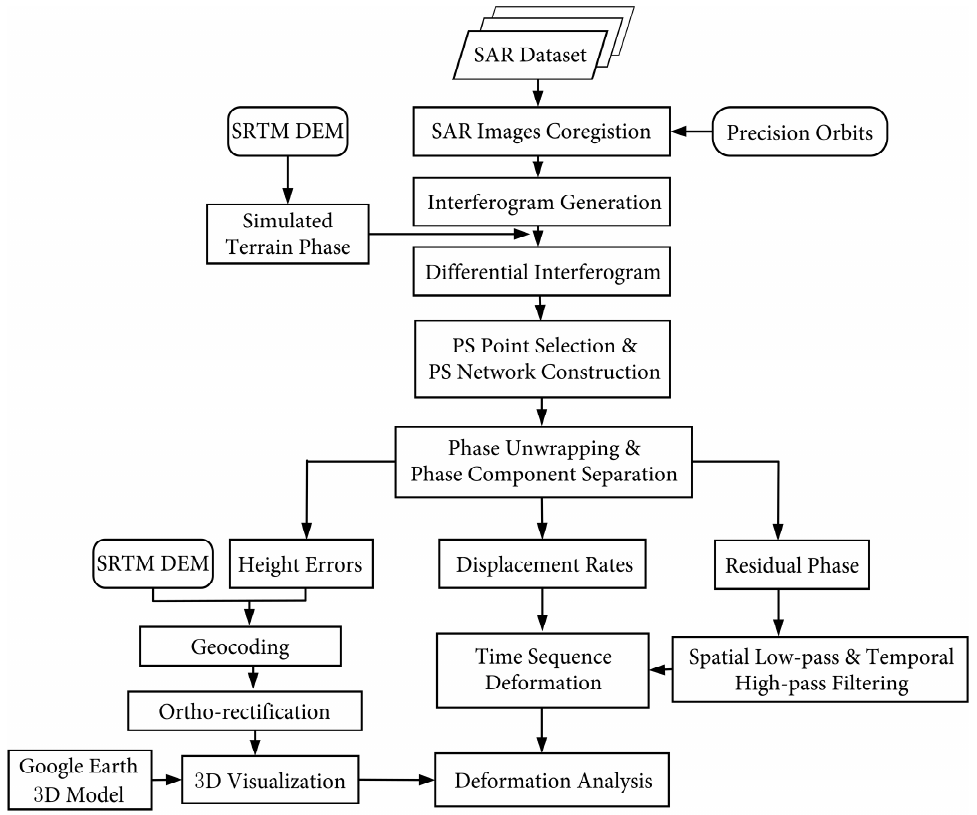
Figure 3. Flowchart of high-resolution permanent scatterer interferometry (PSI) deformation monitoring.